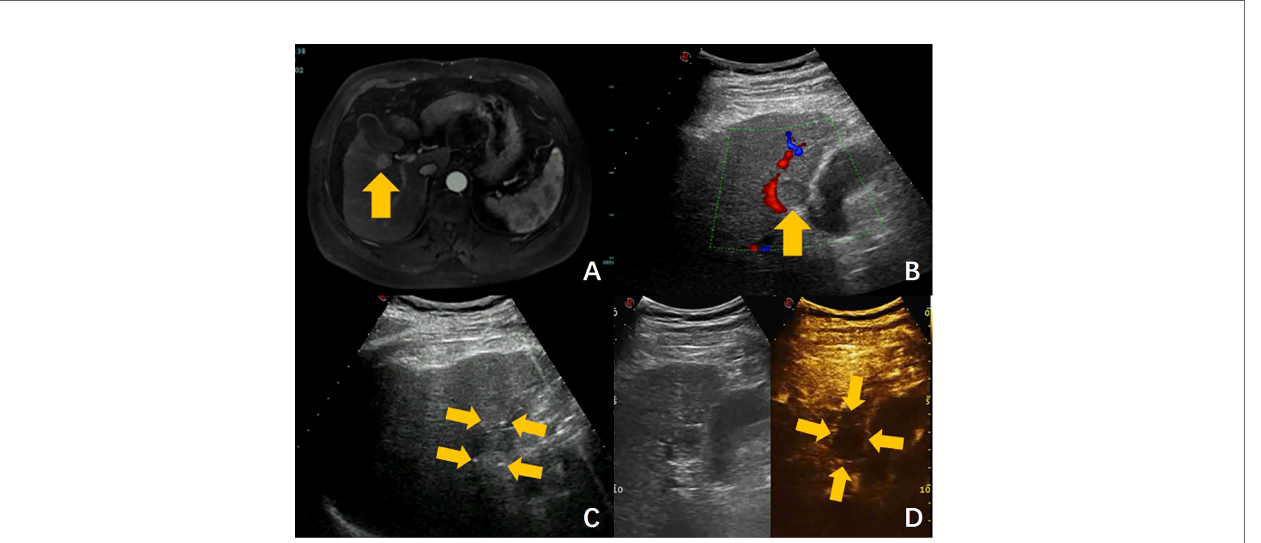
FIGURE 5 | Ultrasound-guided nsPEF procedure for HCC adjacent to gallbladder. (A) Pre-ablation contrast-enhanced MRI revealed a hepatocellular carcinoma adjacent to gallbladder. (B) Ultrasound showed a hypoecho tumor located in close contact with gallbladder and right portal branch (arrow). (C) Ultrasound-guided nsPEF with a two-electrode con fi guration, and the head and tail end of the active tip of the electrodes can have punctuated enhancements (arrow). (D) The contrast- enhanced ultrasound image revealed no enhancement after ablation.